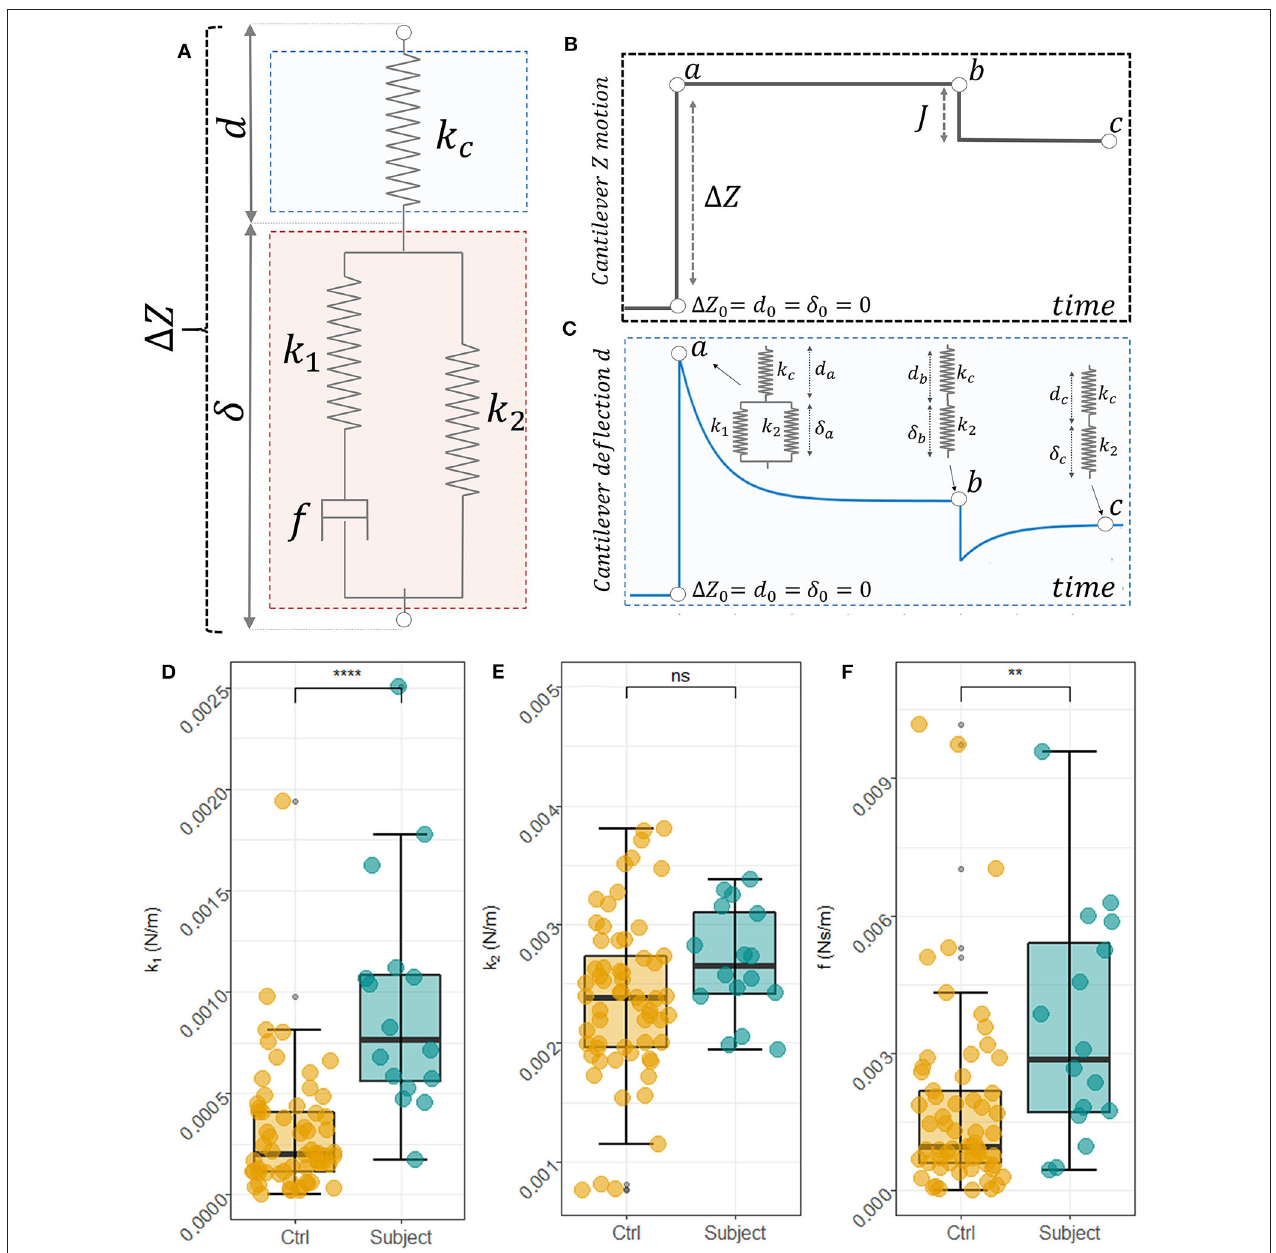
FIGURE 2 | Scheme of the SLS model used to describe RBCs mechanical behavior and interaction with AFM (A) . Schematic view of the cantilever position overtime during the measurements (B) and the corresponding cantilever deflection (C) . In the specific equilibrium points point a , b , and c the mechanical behavior of the sample and the cantilever is represented in the insets of (C) . Box plot analysis of the obtained SLS parameters, namely k 1 (D) , k 2 (E) , and the f (F) for control subjects and the pathological one. An unpaired two-samples Mann Whitney U -Test was used to compare